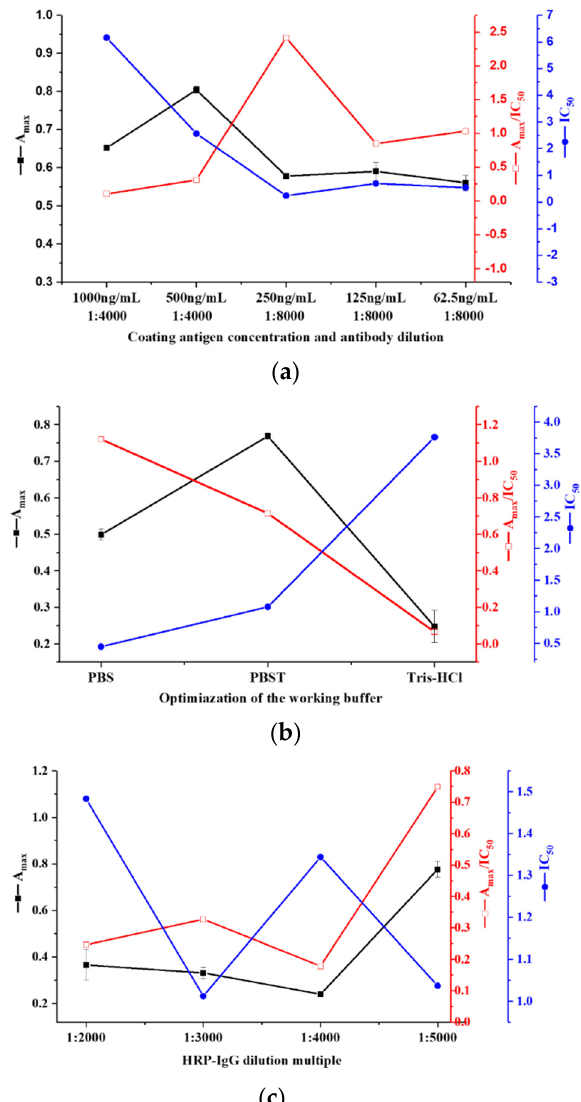
Figure 3. The optimized reaction conditions for icELISA (n = 3). ( a ) Concentration of coating antigen and antibody; ( b ) working buffer for the analyte; ( c ) IgG-HRP dilution multiple. The coating antigen at a concentration of 250 ng/mL, the antibody with a 1:8000 dilution (1 μ g/mL), PBS as a dilution solution, and IgG-HRP diluted 1:5000 were chosen as the optimal working conditions.